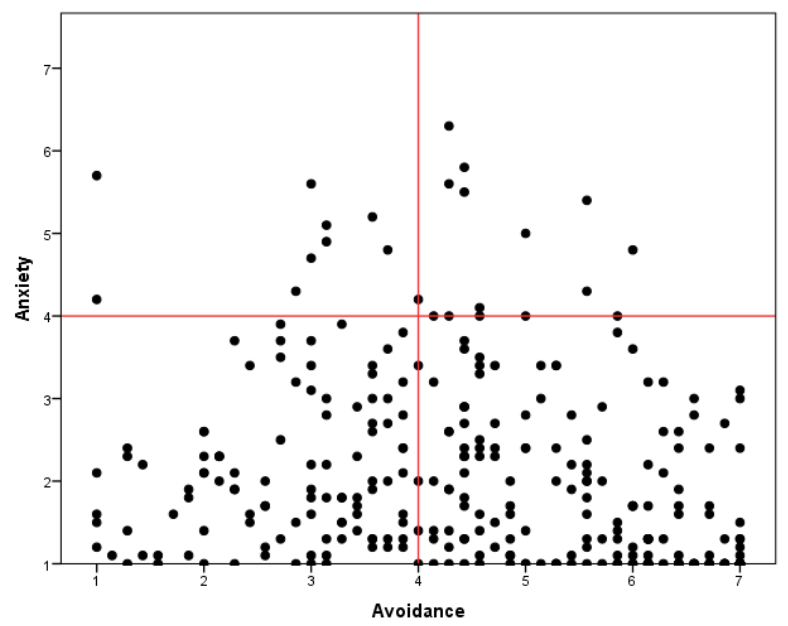
Figure 1. Dispersion of anxiety and avoidance indices.